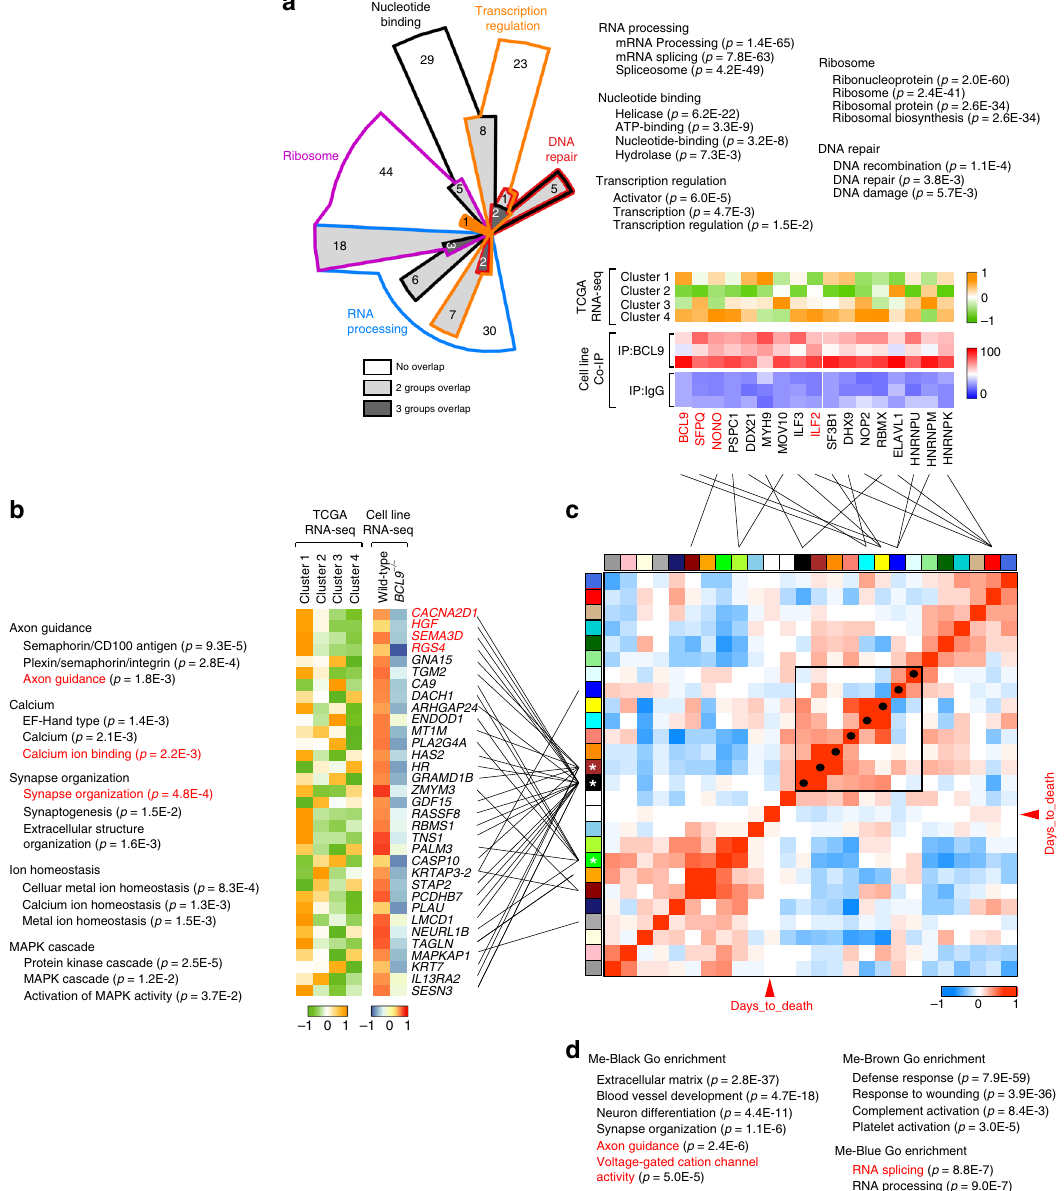
Fig. 2 Transcriptional correlation network of BCL9-associated biological processes in CRC subtypes. a GSEA Chow-Ruskey diagram of BCL9-interacting proteins as determined by IP coupled with MS analysis. Top: Size of colored areas indicates the number of functional gene sets in each module eigengene (ME). Middle: Heatmap of normalized RNA-seq data of indicated genes and CRC clusters. Colors represent normalized RNA-seq expression levels in CRC clusters. Each row represents the mean value of three independent biological repeats. Bottom: Heatmap of IP coupled MS data. Colors represent total peptide number of indicated proteins. b Left: GSEA in pathway gene set for down regulated genes in normalized RNA-seq results of control and BCL9 knockout RKO cells. Middle: heat map of normalized RNA-seq data of indicated genes and CRC clusters. Right: heat map of normalized expression value of RNA-seq results of control and BCL9 knockout RKO cells. c Heatmap of the adjacencies in the eigengene network including patient survival for CRC Cluster 1. Outer boxed heatmap: each colored square in the column or row corresponds to one ME or survival time (red arrowhead). Inner boxed heatmap: blue and red colors represent low adjacency (negative correlation), and high adjacency (positive correlation), respectively. Red squares along the diagonal are the meta-modules. Black dots along this diagonal highlight ME displaying a negative correlation with survival time. Colored interconnecting lines indicate group af fi liation between ME and BCL9-interacting proteins (top) and genes down regulated in BCL9 knockout RKO cells (left). d GSEA of ME- Black (white asterisk), ME-Brown (black asterisk), and ME-Blue (red asterisk) groups. See also Supplementary Figs. 4, 5, 6, 7 and Supplementary Data vector composed of differentially expressed genes between wild-type and BCL9 knockout RKO cells, points towards the C1 direction (Supplementary Fig. 6e). Furthermore, these genes were frequently overexpressed in C1 and its representa- tive cell lines, but not in other CRC patient or cell subtypes (Fig. 2b, right and Supplementary Fig. 6f).